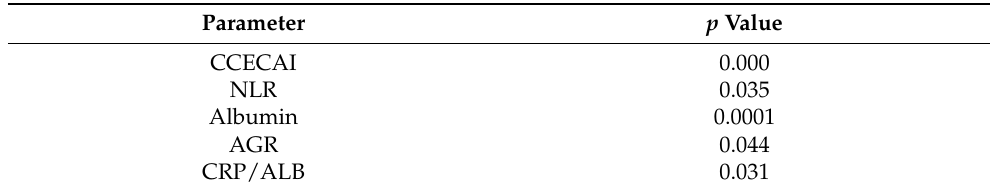
Table 4. The results of the Wilcoxon matched-pairs test used to compare dogs with IRE-PLE before endoscopic procedures (T0) and 1 month after initiation of immunosuppressants (T1).